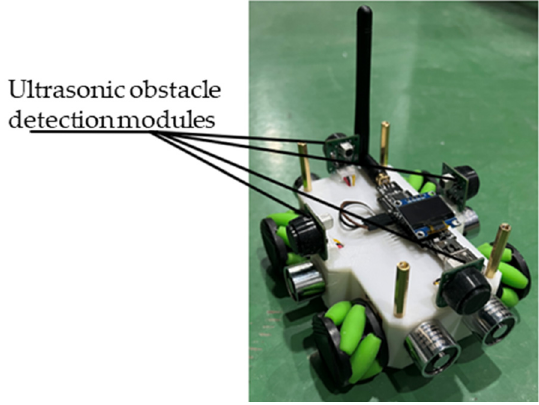
Figure 3. Ultrasonic obstacle detection modules.